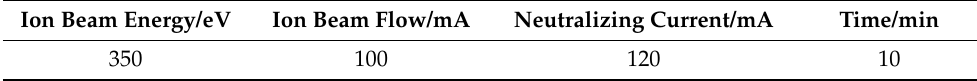
Table 1. Essential parameters of IBE for PR carbonization.